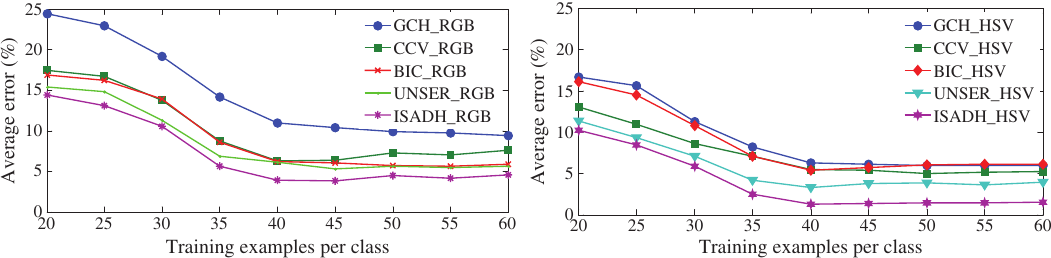
Figure 6. Average Fruit and Vegetable Classification Error using the GCH, CCV, BIC, UNSER, and ISADH Features Considering MSVM as a Base Learner in the RGB and HSV Color Spaces